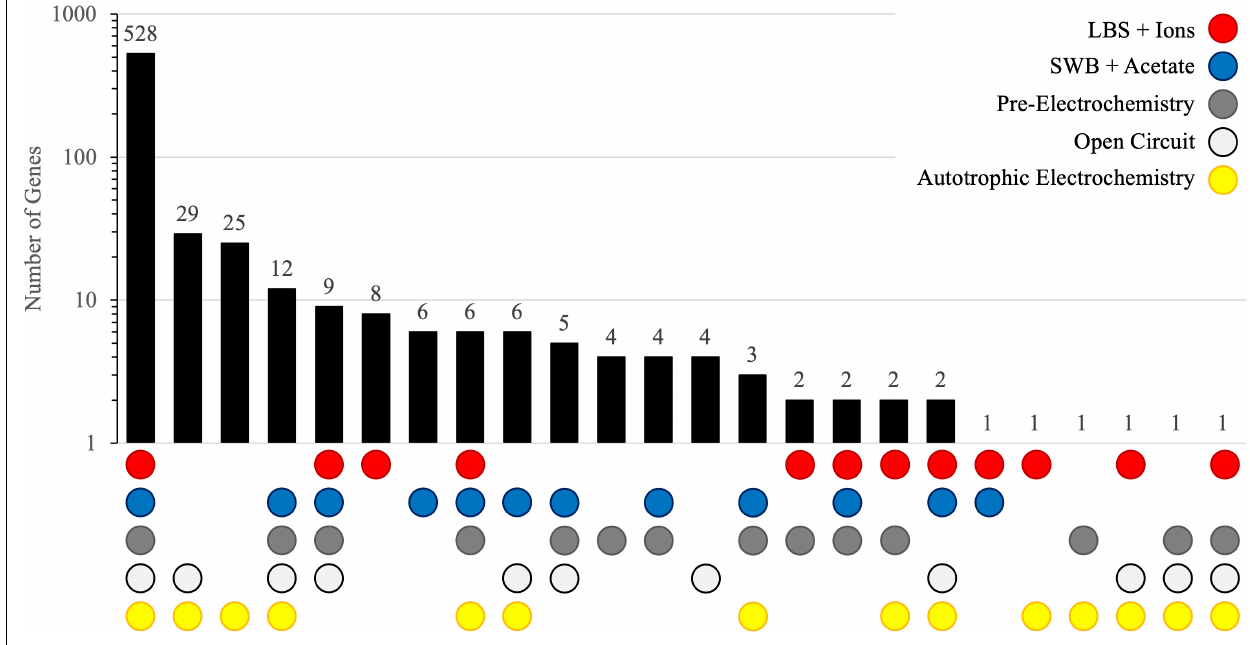
FIGURE 2 | UpSet plot showing the distribution of essential genes identified by Tn-seq under all five growth conditions (LBS + Ions – red circle, SWB + Acetate – blue circle, Pre-Electrochemistry (pre-growth in SWB + Acetate) – gray circle, Autotrophic Open Circuit condition – white circle, and Autotrophic Electrotrophy – yellow circle). Note: y-axis is log